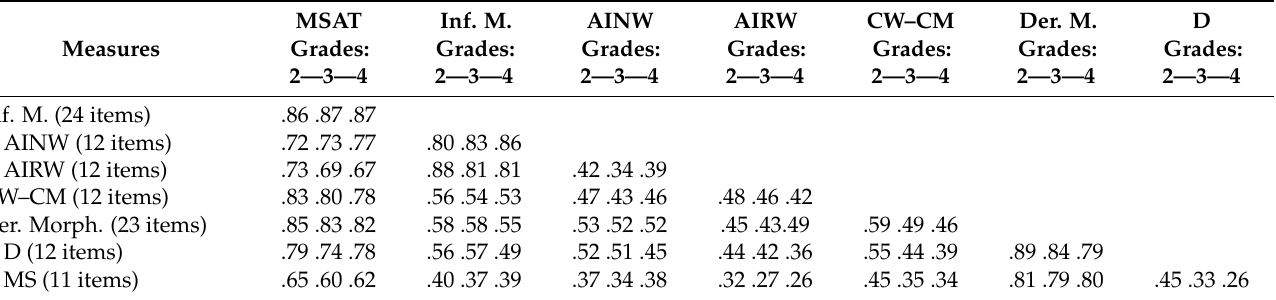
Table 5. Correlations among the Morphological Structure Awareness Test and its subtests.